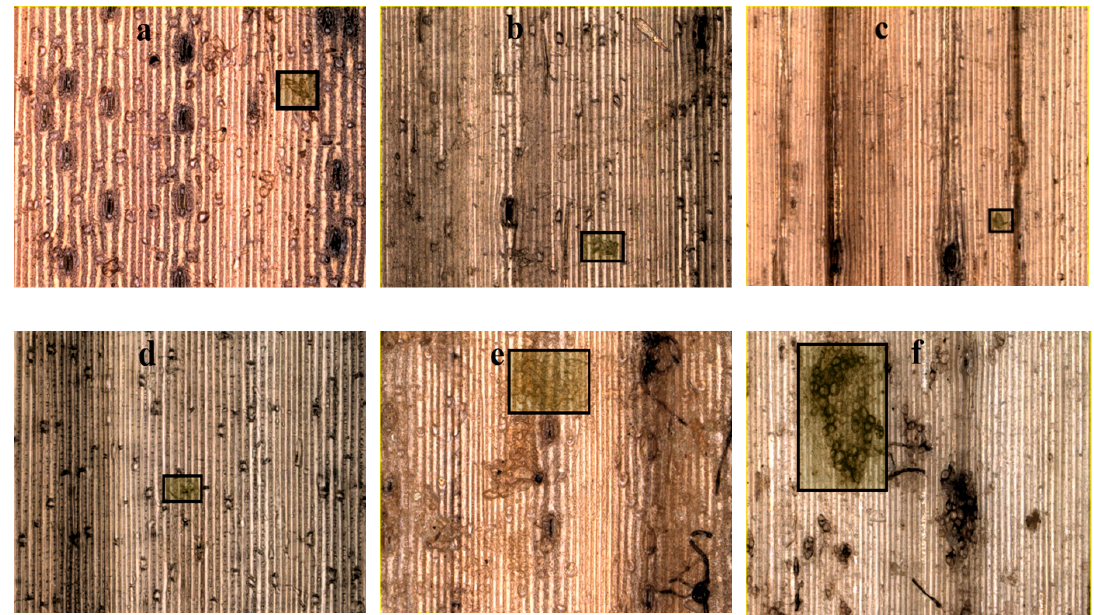
Figure 12. Measurement site of the wheat stalk at different times with plowing tillage. Note: ( a ), ( b ), ( c ), ( d ), ( e ), ( f ) — 2, 3, 4, 5, 6, 7 samplings with plowing tillage.